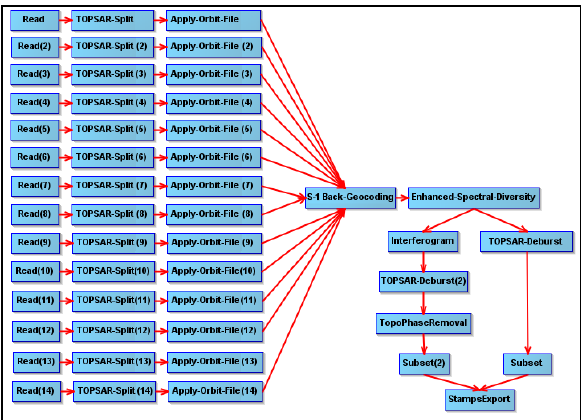
Figure 6. Flow chart of preparing SAR data in SNAP for PSI.